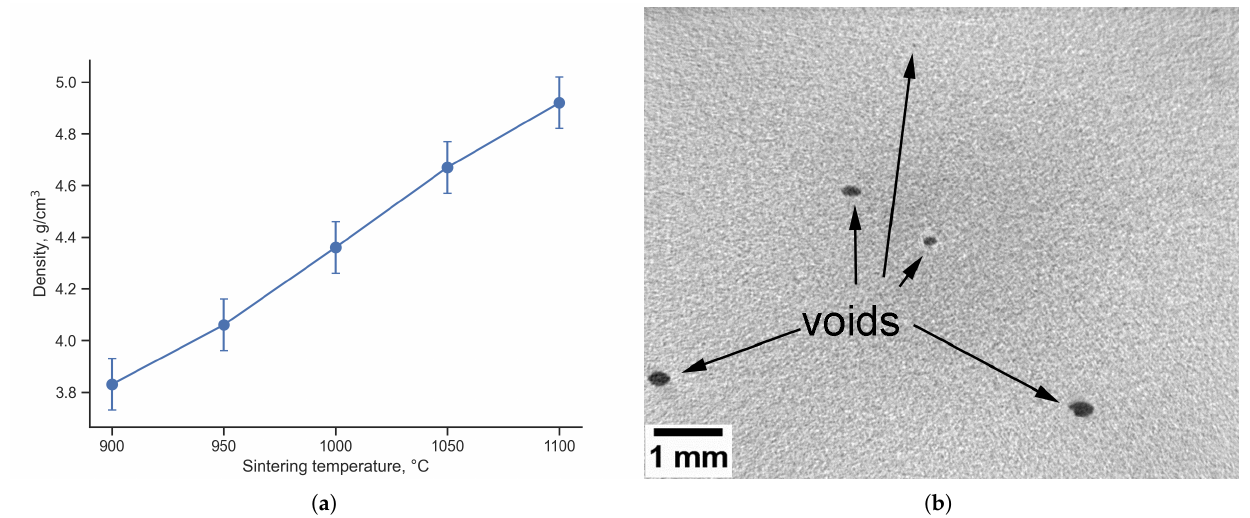
Figure 5. Density of Ti 3 AlC 2 : Cu (1:1) samples after sintering at different temperatures ( a ) and typical X-ray tomography slice image ( b